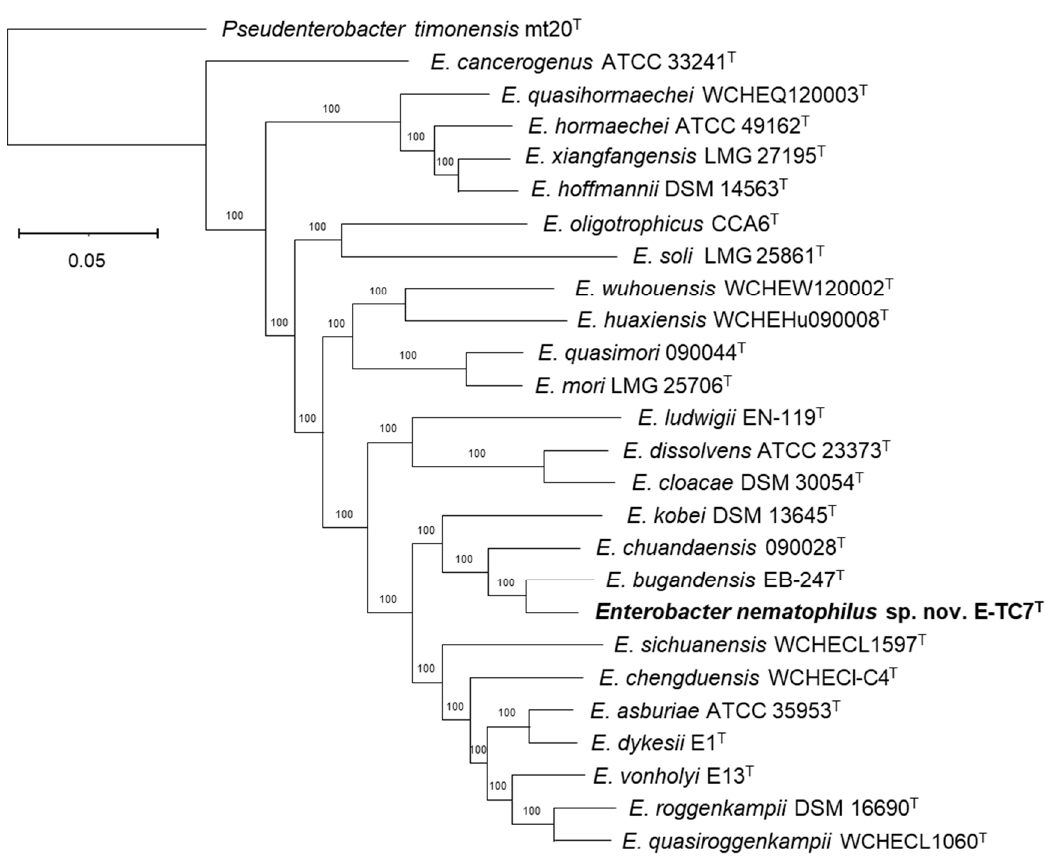
Figure 3. Phylogeny based on core genome sequences of all the species of the genus Enterobacter . 3055395 nucleotide positions (3071 core genes) were used in the analyses. Numbers at the nodes represent SH-like branch supports. Phylogenomic trees were built using FastTree 2.1.10 based on the Generalized Time Reversible Model (GTR) [61]. Accession numbers of the sequences used in the analyses are shown in Table S1. Bold indicates a novel taxonomic proposal. Table 3. Pairwise comparison of digital DNA-DNA Hybridization (dDDH) scores (%) of all the spe- cies of the genus Enterobacter . Accession numbers of the sequences used in the analyses are shown in Table S1. Colors indicate the degree of relatedness between bacterial species pairs.